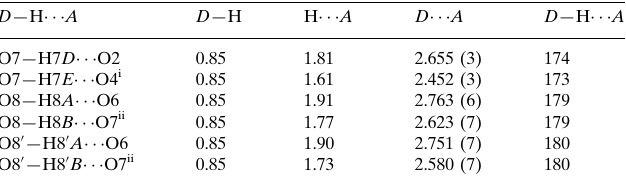
Hydrogen-bond geometry (A˚ , (cid:2)